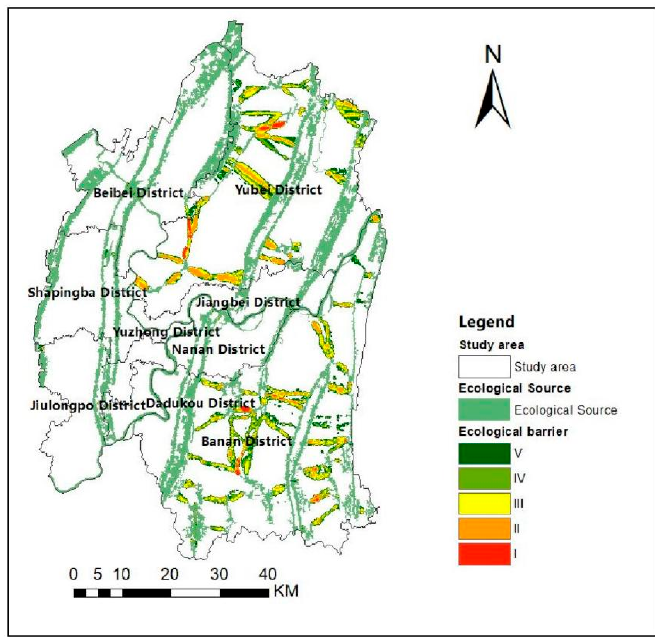
Figure 8. Classification of ecological barriers.